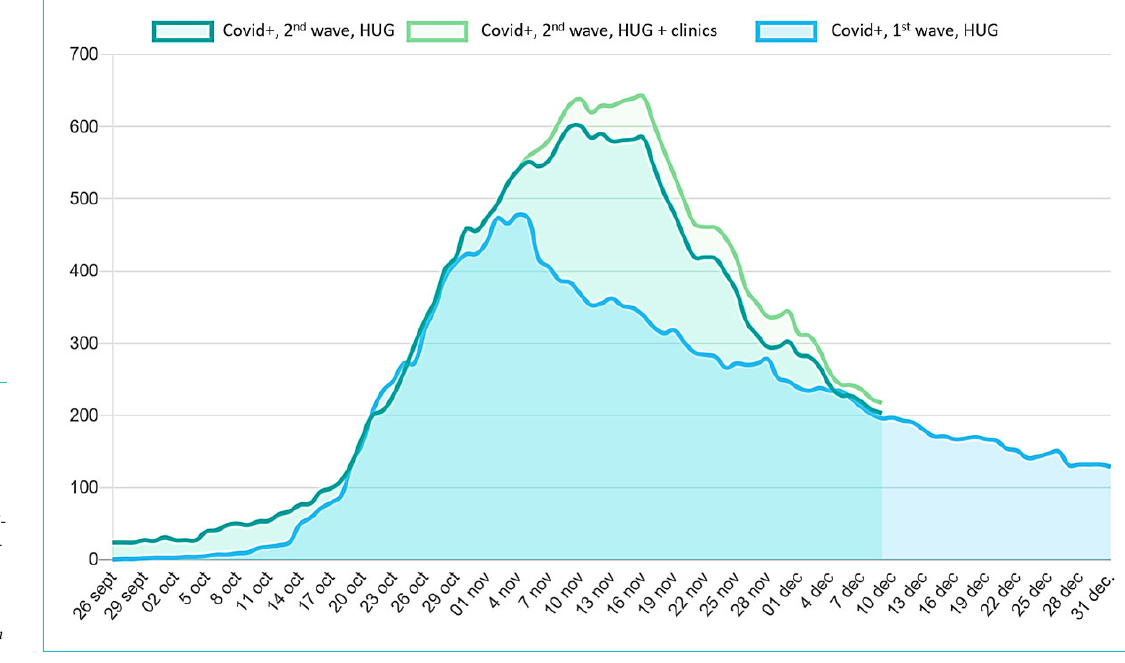
Figure 1: Number of patients hospitalised at the Geneva University Hospitals (HUG) during the first wave (blue-shaded area) and during the second wave (dark green-shaded area). The light green-shaded area indicates all patients hospitalised in the Geneva canton during the sec- ond wave (HUG + other clinics). The dates correspond to the second wave only. Free-access data from http://www.intrahug.ch/groupes/coron-